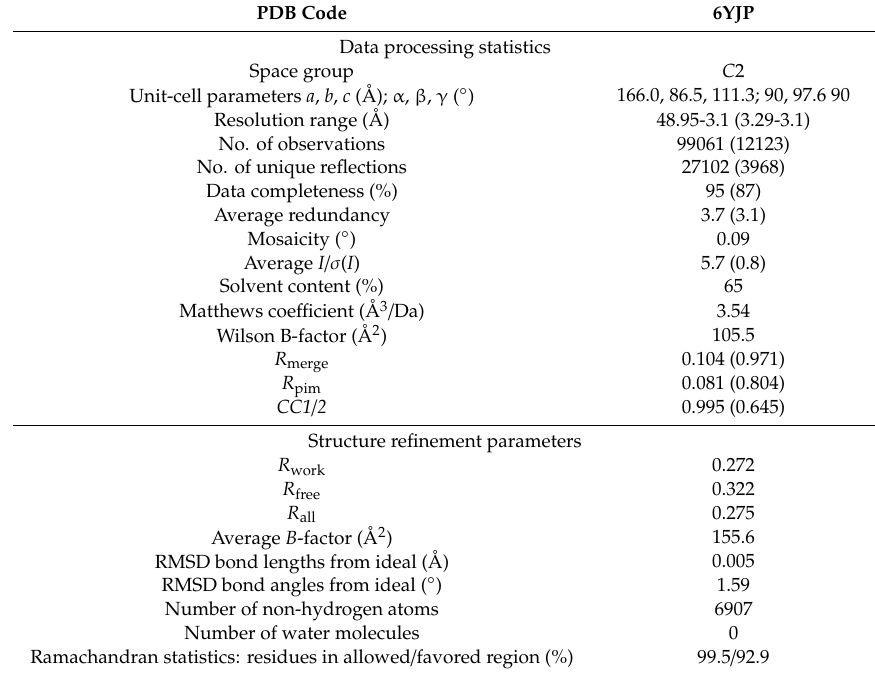
Table 1. Data collection statistics and structure refinement parameters for the NKp30_LBD:B7-H6 crystal structure. Values in parentheses refer to the highest resolution shell.